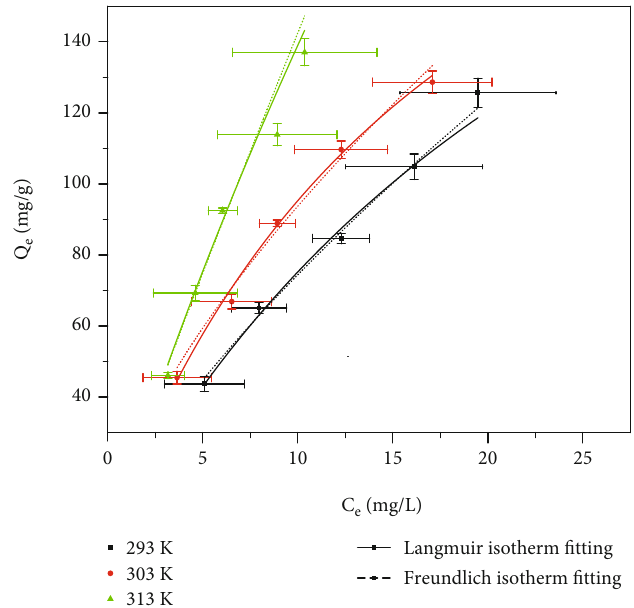
Figure 11: Adsorption isotherm fi